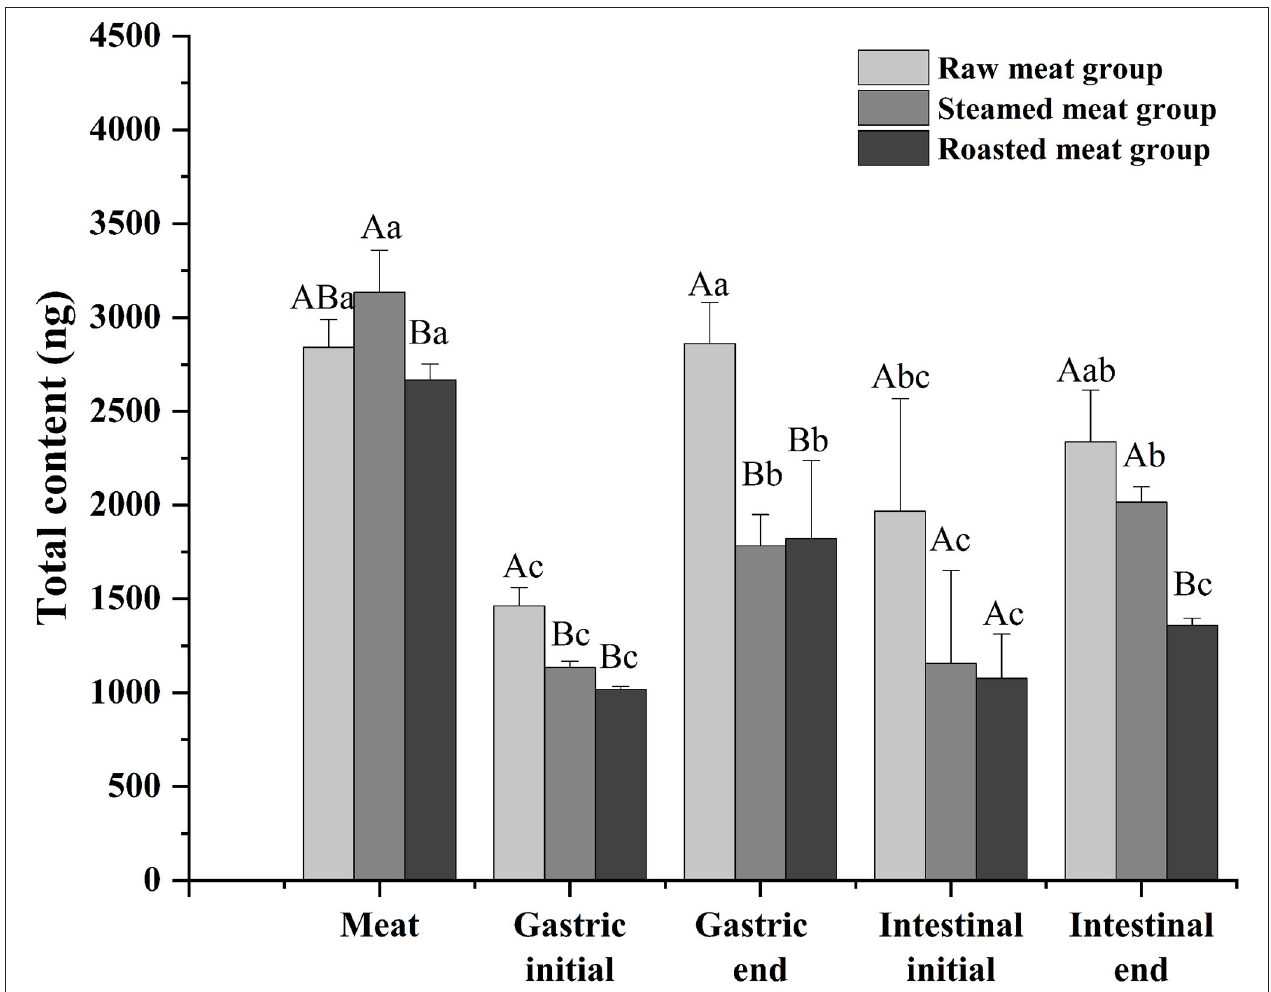
FIGURE 4 | Total content of DEL of oyster meat using three cooking methods at different stages of digestion. Uppercase letters represent differences of DEL content in each digestion stage between different cooking methods (ANOVA, p < 0.05). Lowercase letters represent differences of DEL in the digestion process between the same cooking methods (ANOVA, p <